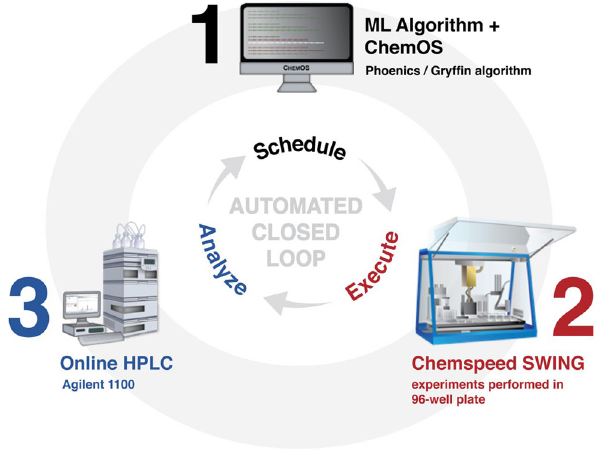
Fig. 2 Closed-loop system for autonomous optimization in batch. The three main components to enable this closed loop include (1) ChemOS to coordinate experiments and data-driven approaches, (2) Chemspeed SWING for automated experimental setup, and (3) Agilent 1100 to characterize the experimental outcomes.